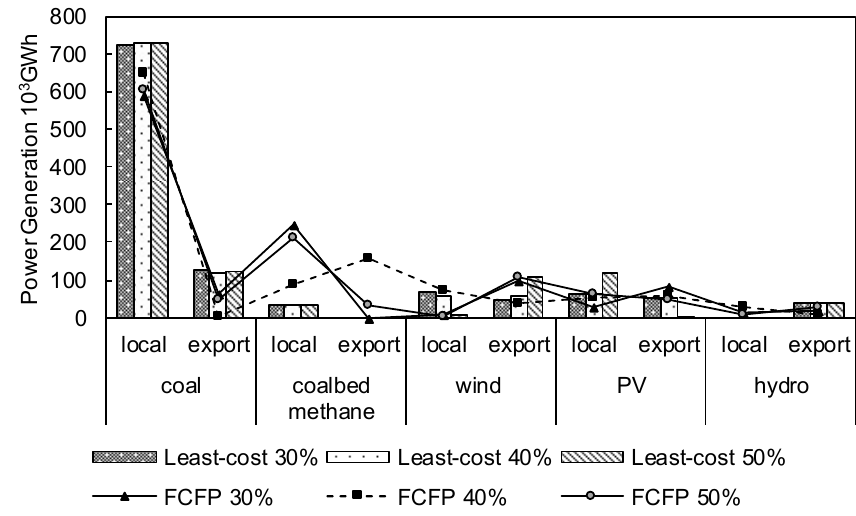
Figure 10. Power generation patterns under different export electricity scenarios.